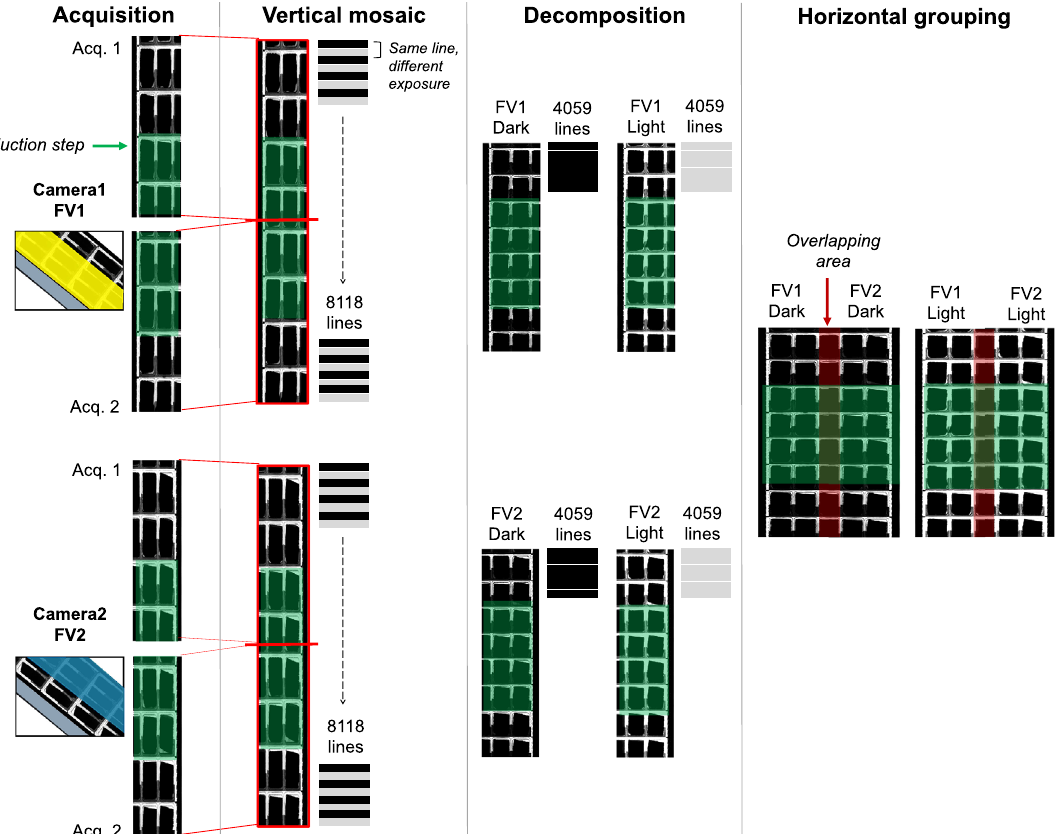
Figure 2. Sequence of images obtained during the acquisition process. From left to right: Acquisition contains images of two consecutive steps from Camera 1 (FV1) and Camera 2 (FV2) that together cover the whole field of view (FV); Vertical mosaic contains images from the vertical combination of the two consecutive acquired images; Decomposition contains images obtained from the division of the combined image into two images with different exposure; and Horizontal grouping contains the final images with different exposure that will be analyzed.